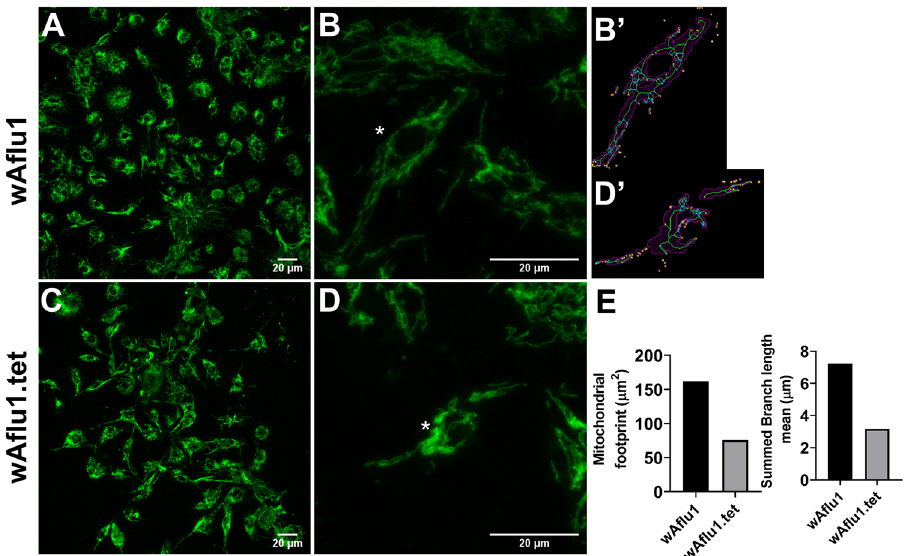
Figure 6. Mitochondrial staining on Aedes fluviatilis cell lines. Mitochondrial staining on Aedes fluviatilis cell lines wAflu1 (Wolb+) and wAflu1.tet (Wolb−) was detected using MitoTracker specific staining ( A , C ), respectively. Mitochondria change distribution in presence of Wolbachia showing more diffuse marking in wAflu1 ( B ) than wAflu1.tet ( D ) cell culture. The ( B ′ , D ′ ) represent the analysis of the cell indicated by an asterisk in ( B , D ) and magenta region is the binarized signal used for calculating the area ( E ). The green lines are the morphological skeleton and yellow dots represent the end points of the skeleton and the blue dots